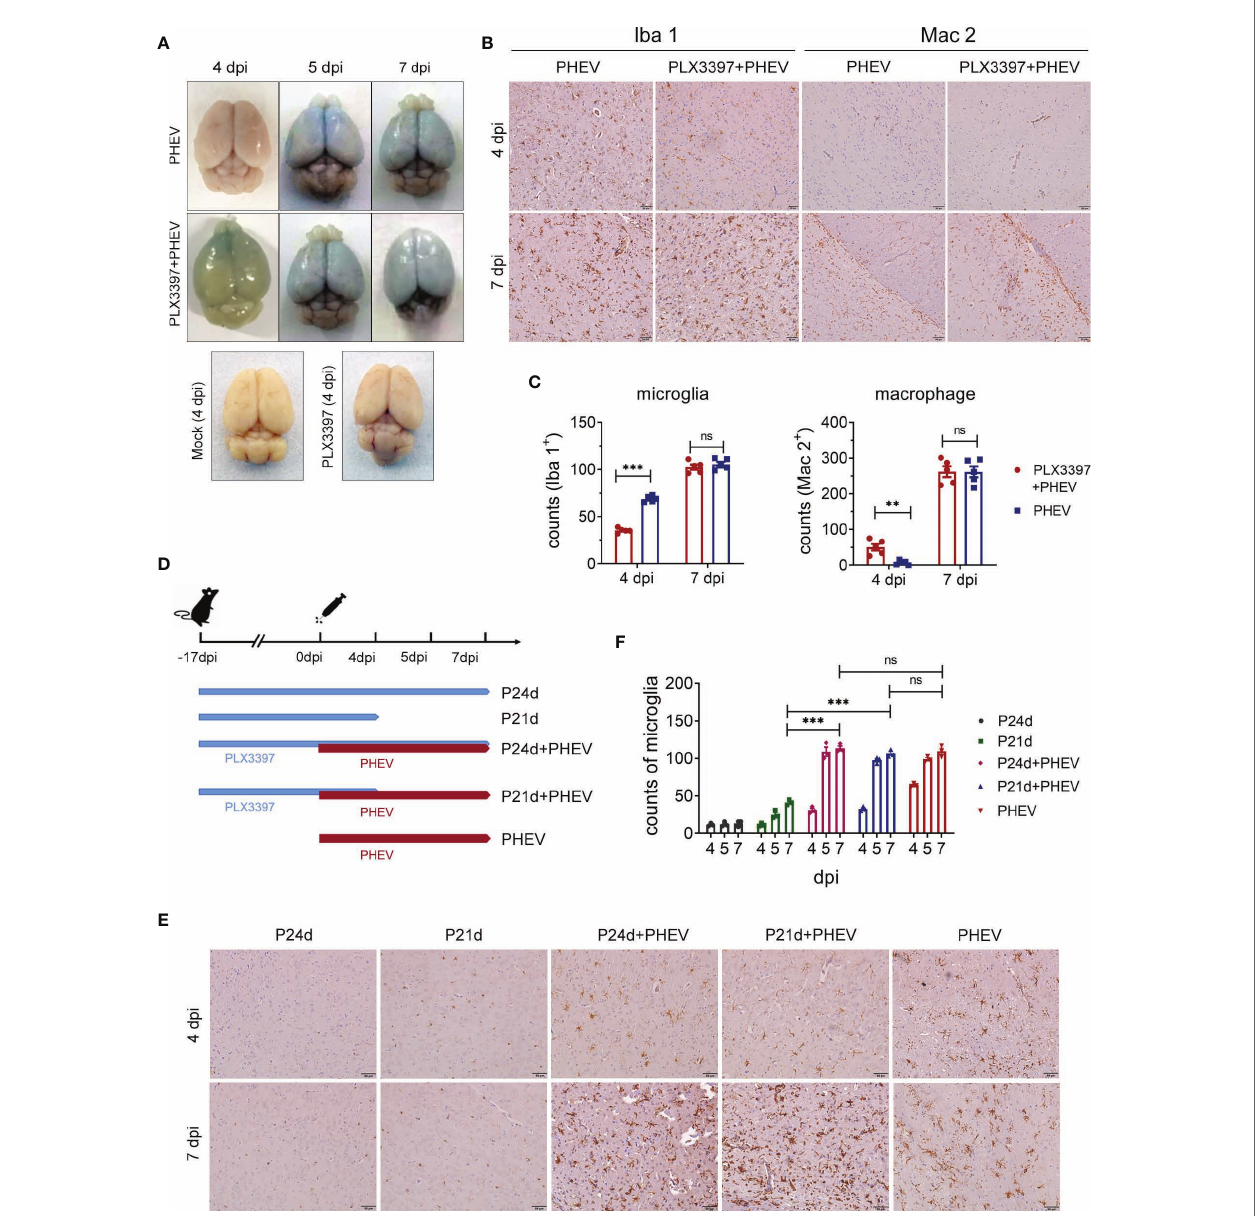
FIGURE 3 | PHEV-speci fi c excess microglial activation promotes BBB disruption and macrophage in fi ltration. (A) BBB destruction in PLX3397-administered mice was evaluated by i.v. injecting Evans blue (EB) at 4, 5, 7 dpi. (B) IHC staining of mice brain tissues. Microglia and in fi ltrated peripheral monocytes/macrophages were labeled with antibodies against Iba 1 and Mac 2, respectively. Bars, 2 m m. (C) Numbers of Iba 1 + cells and Mac 2 + cells. Five fi elds per group were analyzed. (D) Procedure of PLX3397 administration and PHEV infection. (E) IHC evaluation of microglial activation at 4 and 7 dpi. (F) Counts of Iba 1-labeled microglia. Statistical analyses were performed using Student ’ s t test (**, P<0.01; ***, P<0.001) ns, Not Signi fi